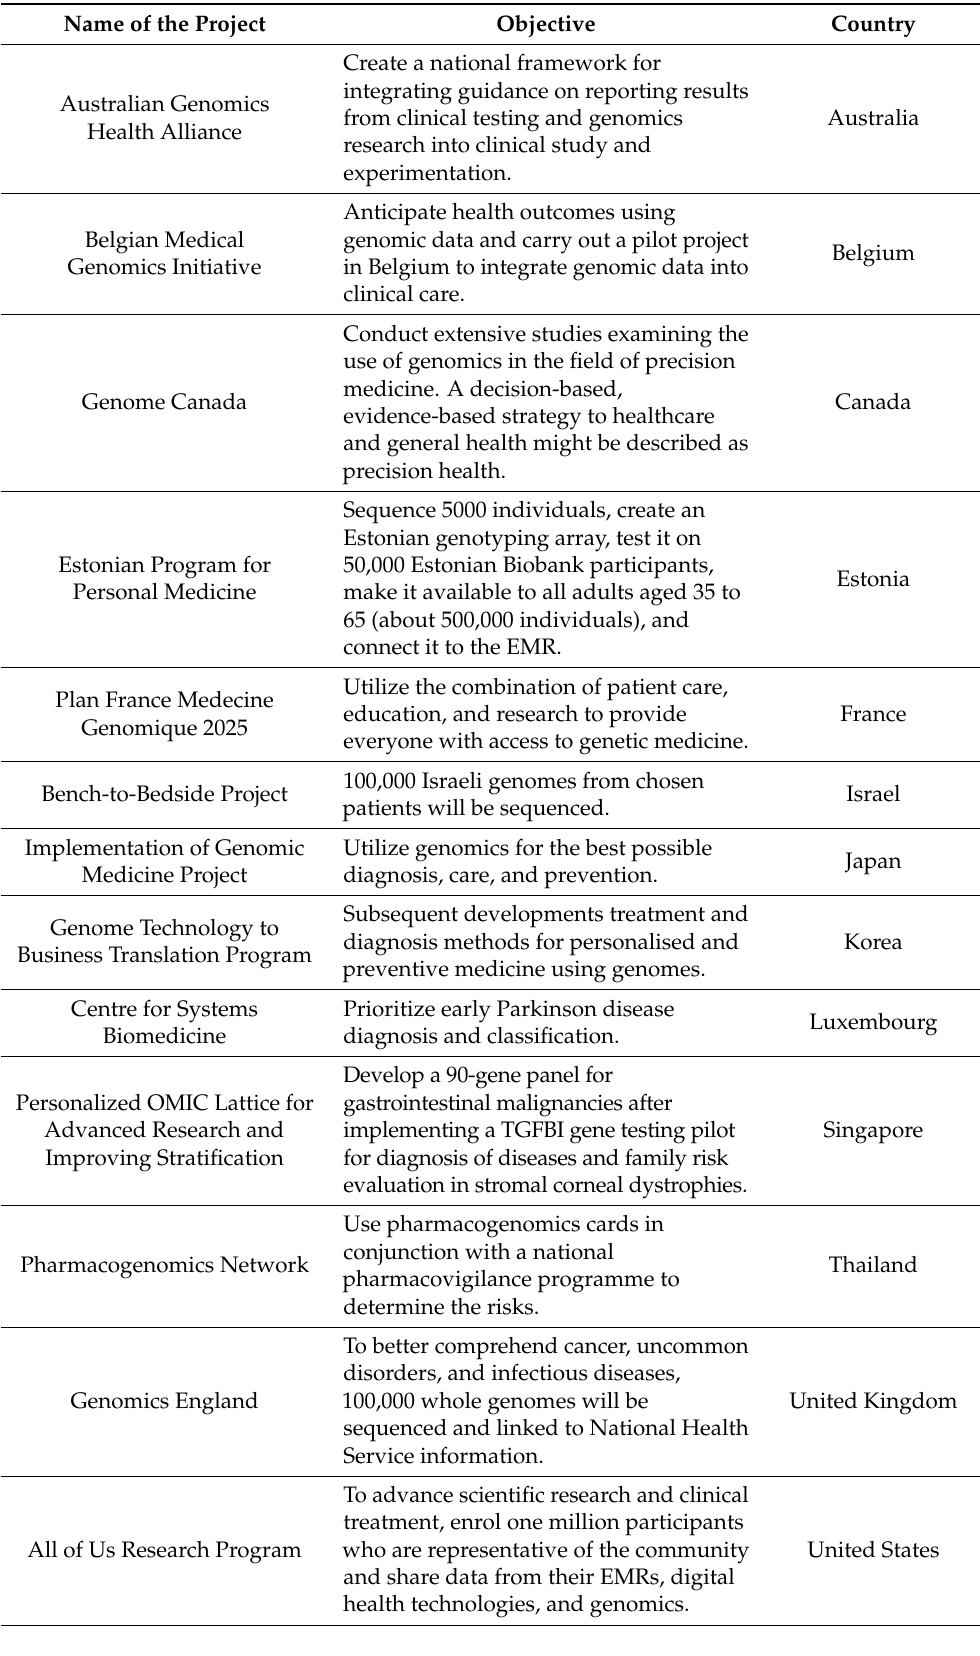
Table 2. Projects being implemented worldwide to use precision